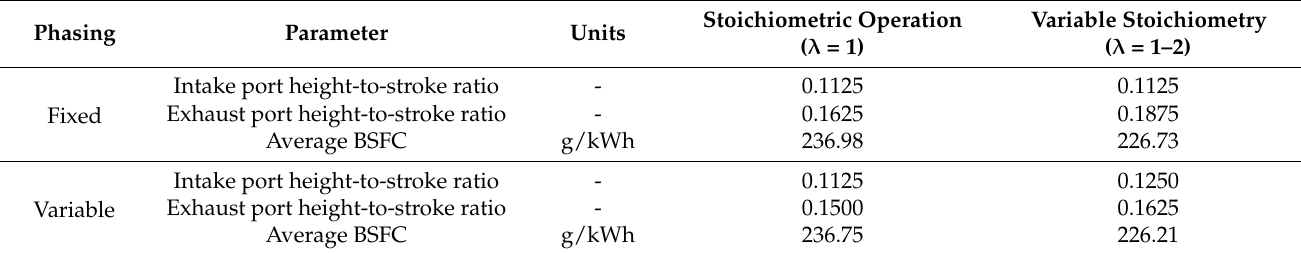
Table 6. Optimal port heights for medium-duty operating points A, B, and C (1500 min − 1 , 3-bar BMEP; 1500 min − 1 , 12-bar BMEP; and 3000 min − 1 , 10-bar BMEP, respectively) for both stoichiometric and lean operation, and under both fixed- and variable-phasing scenarios. Average BSFC is calculated as an equally weighted mean of the best efficiency points at operating points A, B, and C.